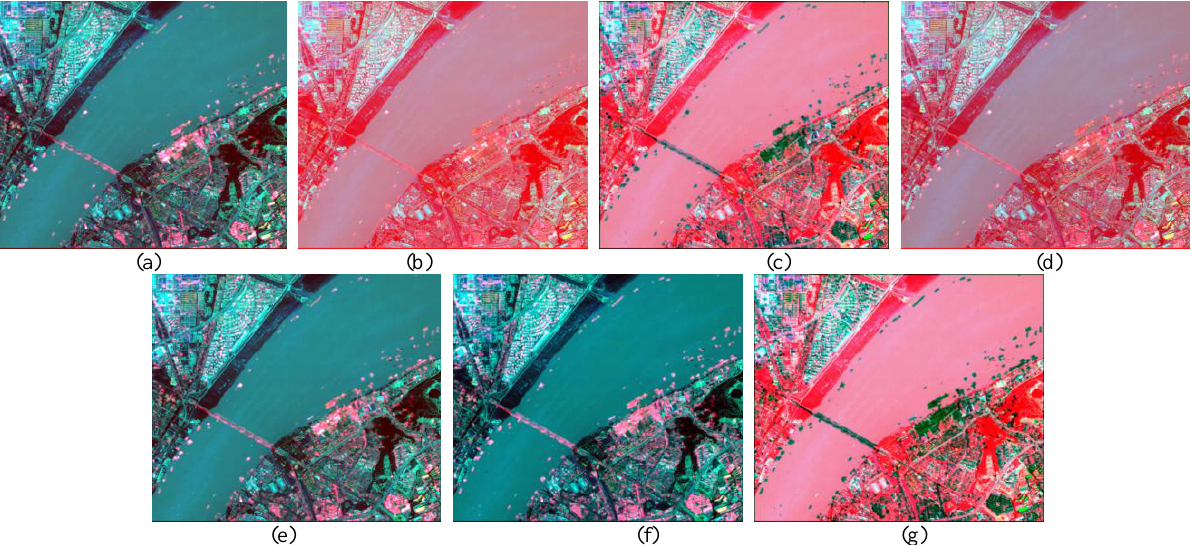
Figure 2. (a) ~ (g) are correlations between texture measures in different windows. (The corresponding sequence is Mean, Variance, Homogeneity, Contrast, Dissimilarity, Entropy, and Second Moment.). (h) The standard deviation of the textural measures in different windows.